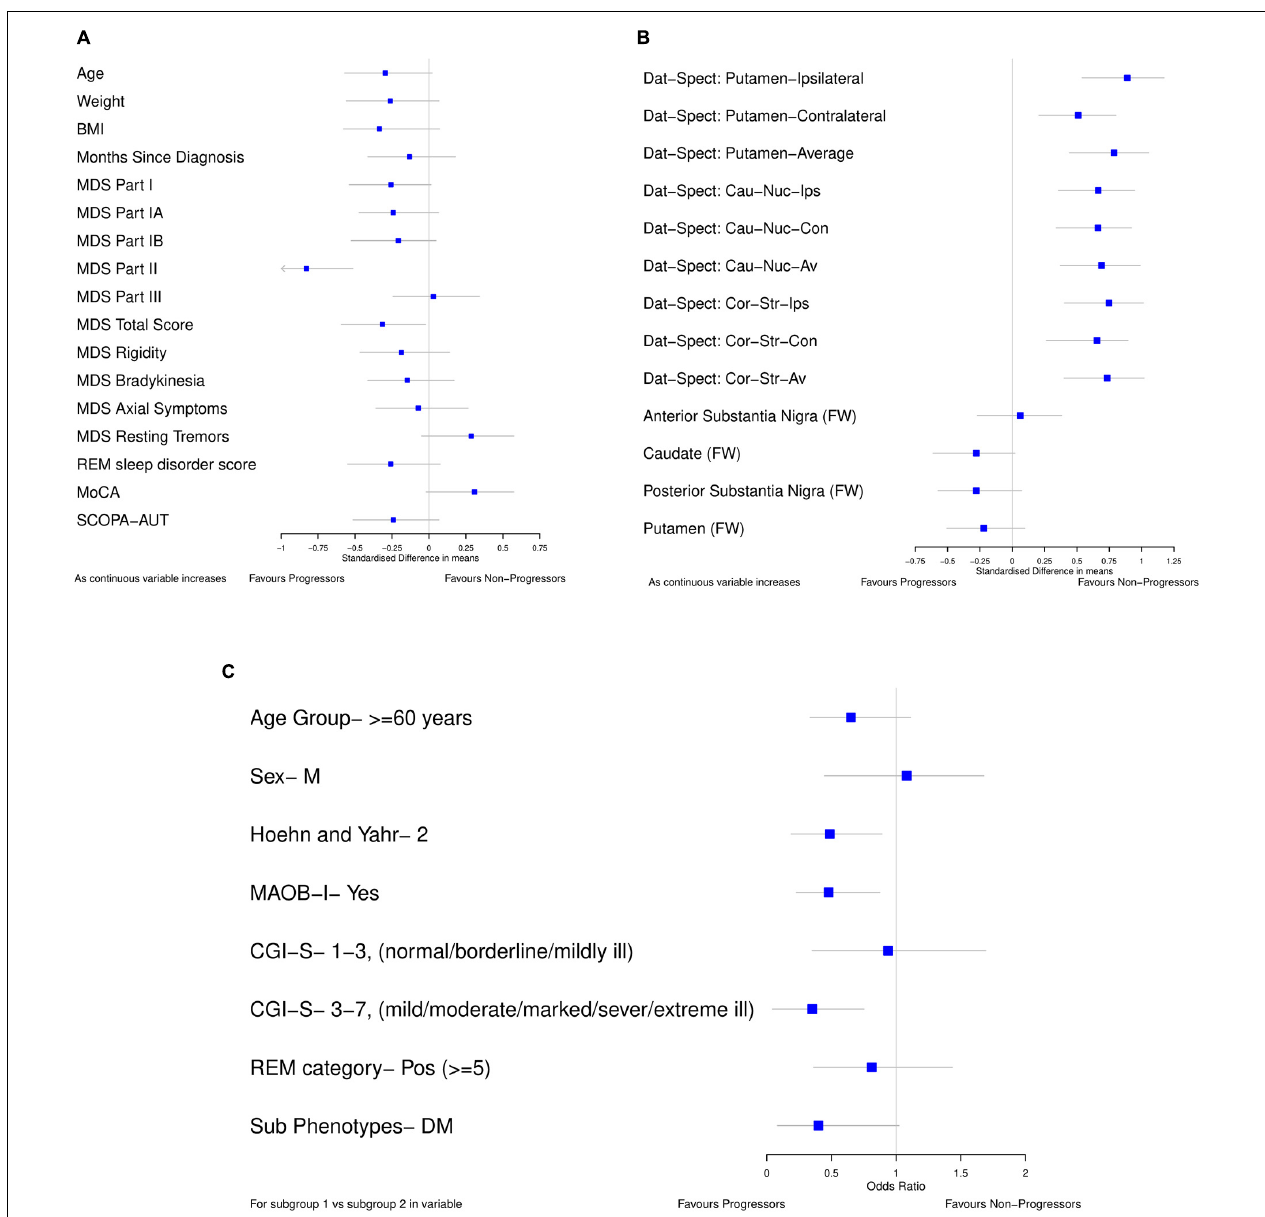
FIGURE 2 | Forest plots showing difference in baseline characteristics between progressors and non-progressors in the placebo arm from PASADENA. (A,B) Standardized mean difference (80% confidence intervals). (C) Odds ratio (80% confidence intervals); for each variable, the reference group is listed. All plots were calculated using 1000 bootstrap